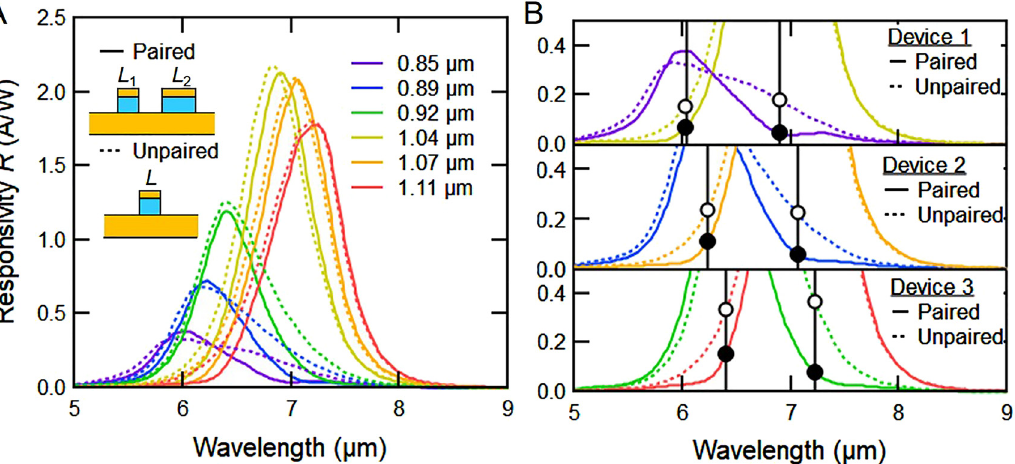
Figure 6: A) Experimental unpolarized R of paired quantum well infrared photodetector (QWIP) stripes from dual-band devices (solid) and unpairedQWIPstripeswithidentical L (dotted).Oneperiod of eachstructureis shownschematically for comparison.An unpairedQWIPstripe with L = 0.93 μ m is shown to be compared with the paired QWIP stripe with L 1 = 0.92 μ m due to lack of an unpaired QWIP stripe at the exact dimensions.B)Close-upof A)forrespectivedevices.Non-resonant R inpairedQWIPsaroundtheircounterpart ’ sresonancewavelength(black vertical lines). Black fi lled circles indicate values of experimental non-resonant R in paired QWIP stripes. Black un fi lled circles indicate values of non-resonant R corresponding unpaired QWIP stripes (dotted lines). All experimental R is calibrated, thus independent of the device